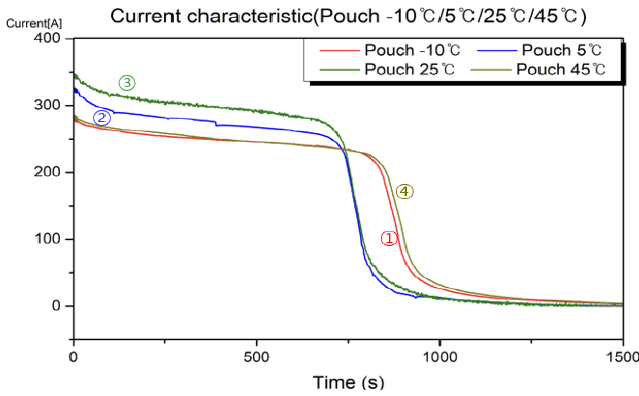
12 of 16 Figure 11. Current status of prismatic cell during testing according to preprocessing temperature. On the other hand, Figure 12 shows the current profiles depending on the prepro- cessing temperature in the pouch-type battery. Graphs ➀, ➁ , ➂ and ➃ in Figure 11 are the current profiles of the external short circuit under the preprocessing temperatures of − 10